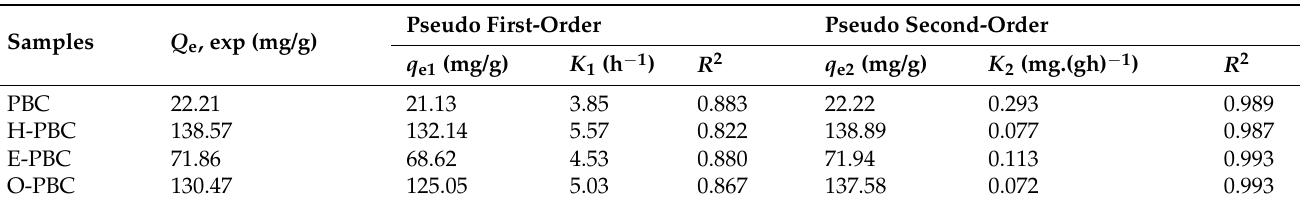
Table 5. Kinetic parameters for pseudo-first order and pseudo-second order models of Pb(II) adsorp- tion by PBC, H-PBC, E-PBC, and